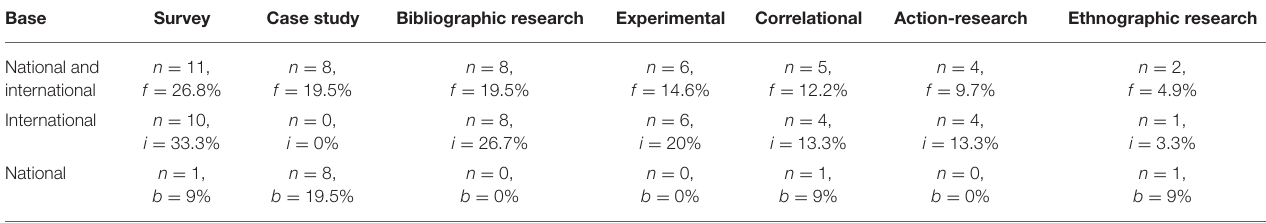
TABLE 6 | Types of research.